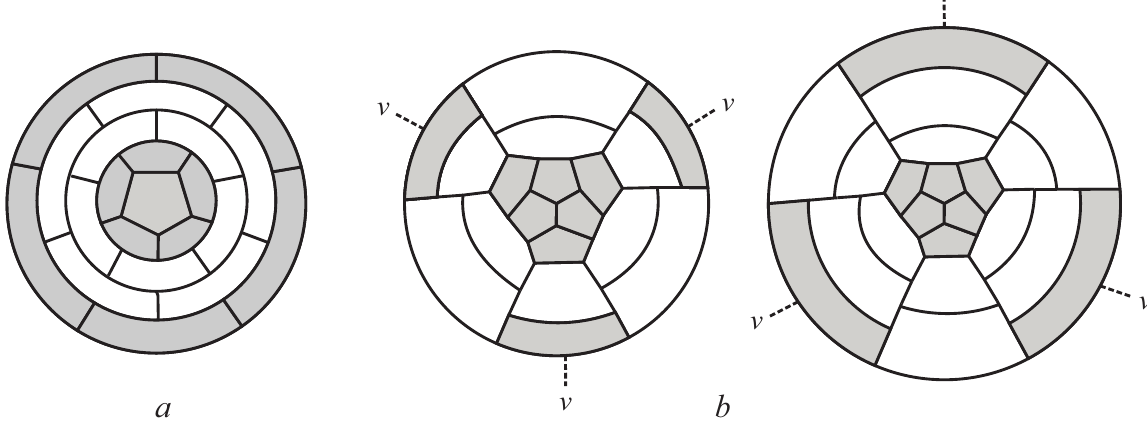
Figure 5. Structure of fullerene graphs with caps of types ( a ) and ( b